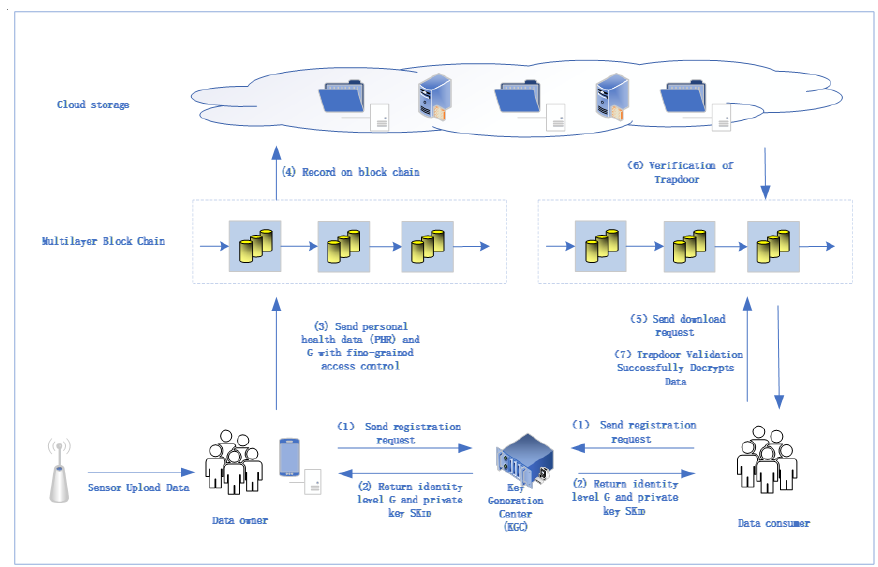
Figure 5. Blockchain-based healthcare IoT layered data-sharing reconstruction diagram.